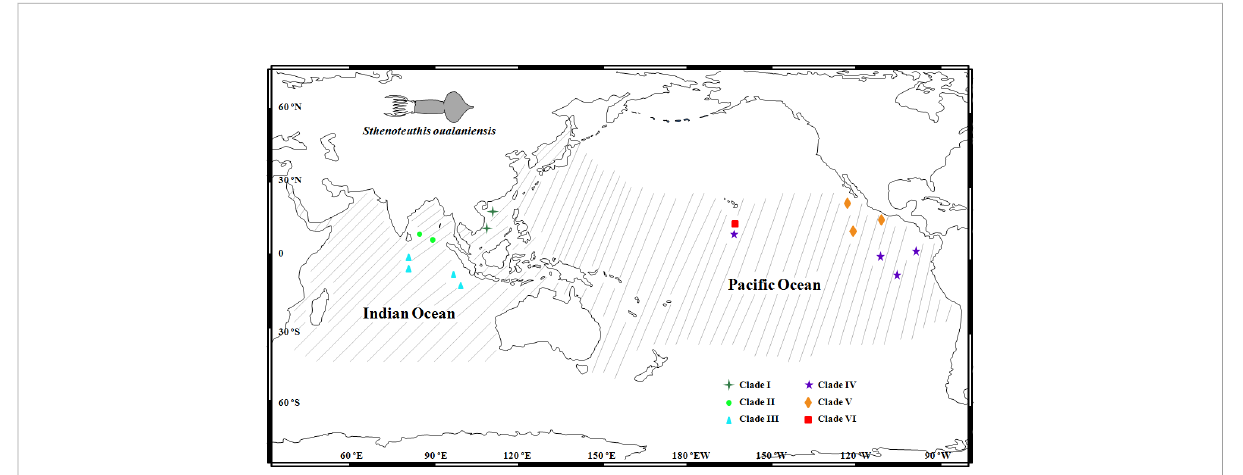
FIGURE 1 Sampling localities and spatial distribution of six clades in the East Indian Ocean and Paci fi c Ocean modi fi ed from Staaf et al. (2010). Geographic distributional range of Sthenoteuthis oualaniensis is indicated by gray